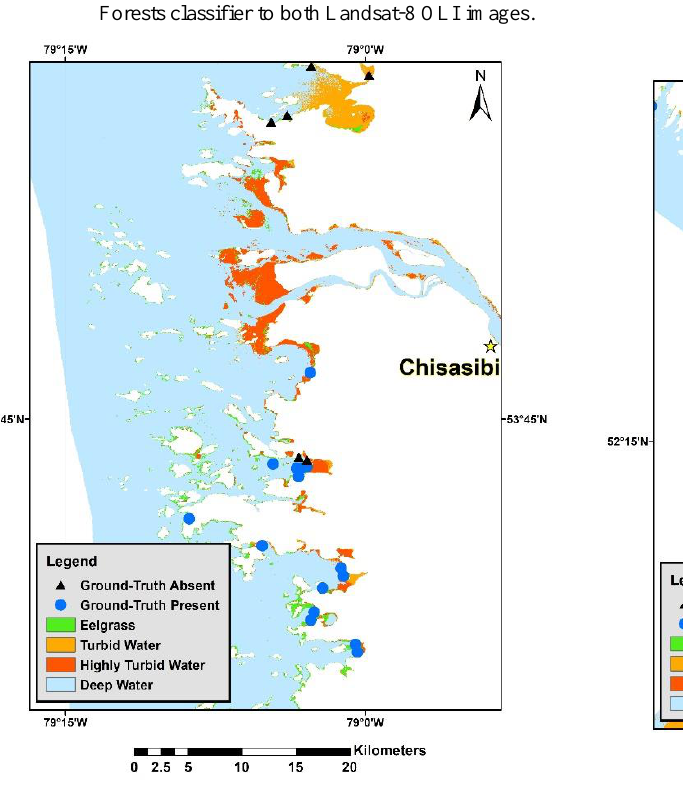
Figure 8. Classified image produced by applying the Random Figure 10. Classified image produced by applying the Random Forests classifier to both Landsat-8 OLI images for Forests classifier to both Landsat-8 OLI images the coastline around Chisasibi. outlining the coastline around